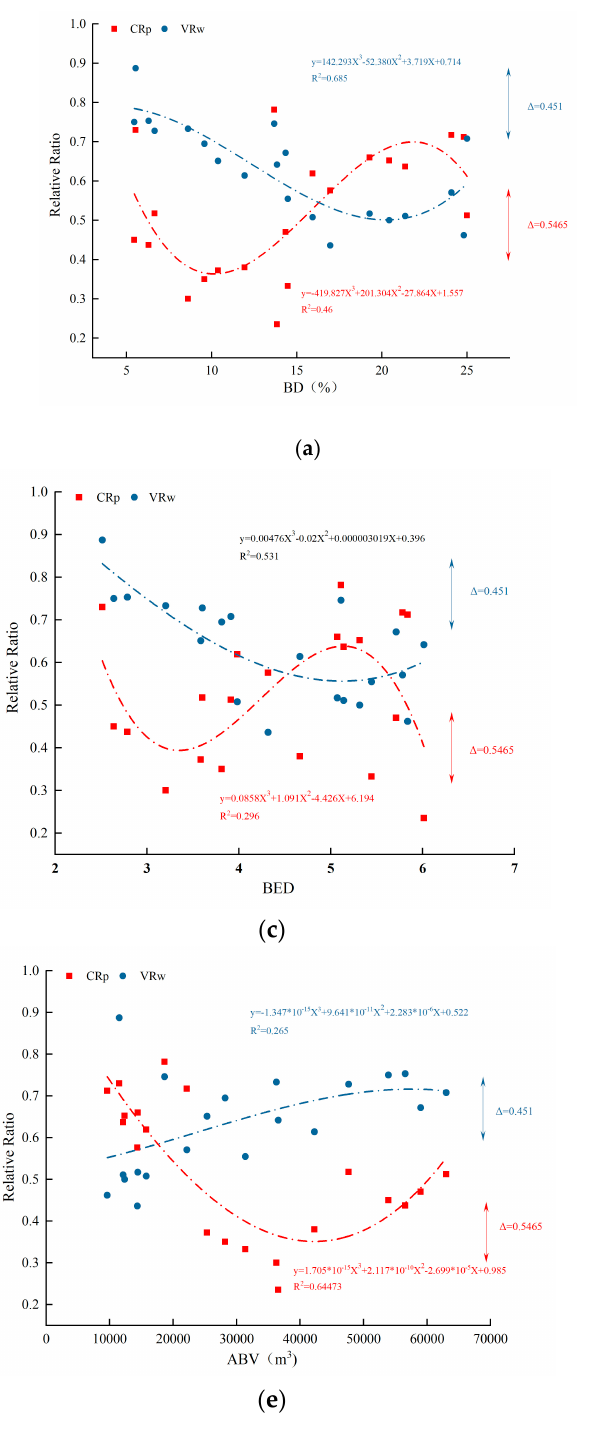
Figure 8. Curve fitting of different morphological parameters with PM 2.5 and wind speed: ( a ) BD; ( b ) GCR; ( c ) BED; ( d ) ABF; ( e ) ABV; ( f )